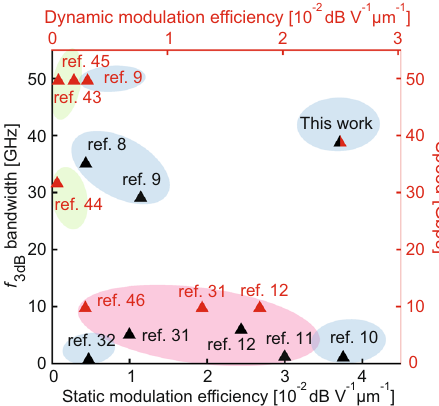
Fig. 4 Comparison with other optical modulators. The black and red data points and axis represent the static modulation ef fi ciency as a function of the f 3dB bandwidth and the dynamic modulation ef fi ciency (extracted from eye diagrams) as a function of the modulation speed, respectively. The red, blue, and green data clouds enclose single- 11,12,31,46 and double-layer 8 – 10,32 graphene and silicon 43 – 45 state-of-the-art modulators operating at λ = 1.55 μ m. Refer to Supplementary Notes 15 and 16 for a more detailed comparison of graphene-based